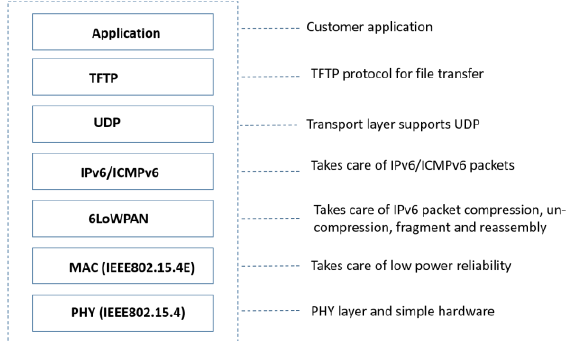
Figure 3. RapidNet IP stack used by ESL